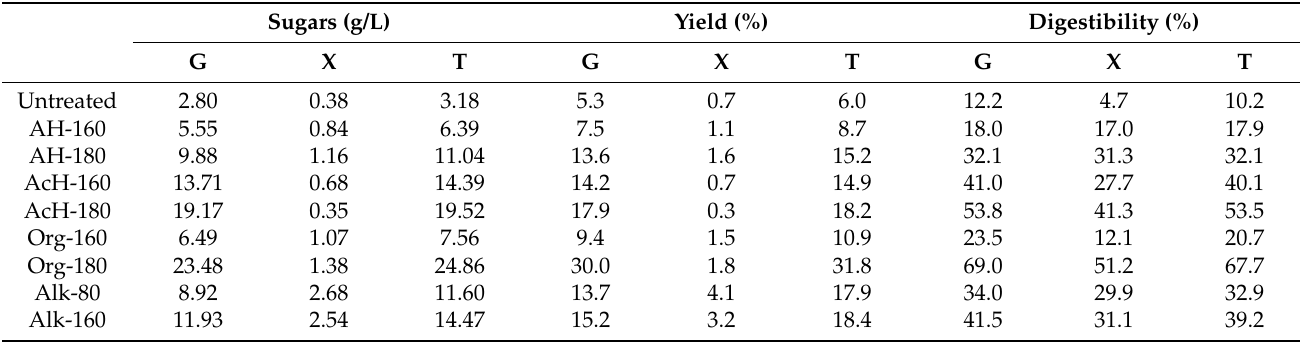
Figure 6. Time course of sugars production during enzymatic hydrolysis of the pretreated materials (WIS fraction) re- sulting from the different pretreatments of Ademuz elm clone. AH, autohydrolysis pretreatment; AcH, acid hydrolysis; Org, organosolv pretreatment; Alk, alkaline extraction. Mean values and standard deviations were calculated from the triplicates. Table 5. Sugar production (g/L), yield (%) and digestibility (%) values of Ademuz elm clone (untreated) and their materials (WIS fraction) resulting from the different pretreatments at 144 h of enzymatic hydrolysis.